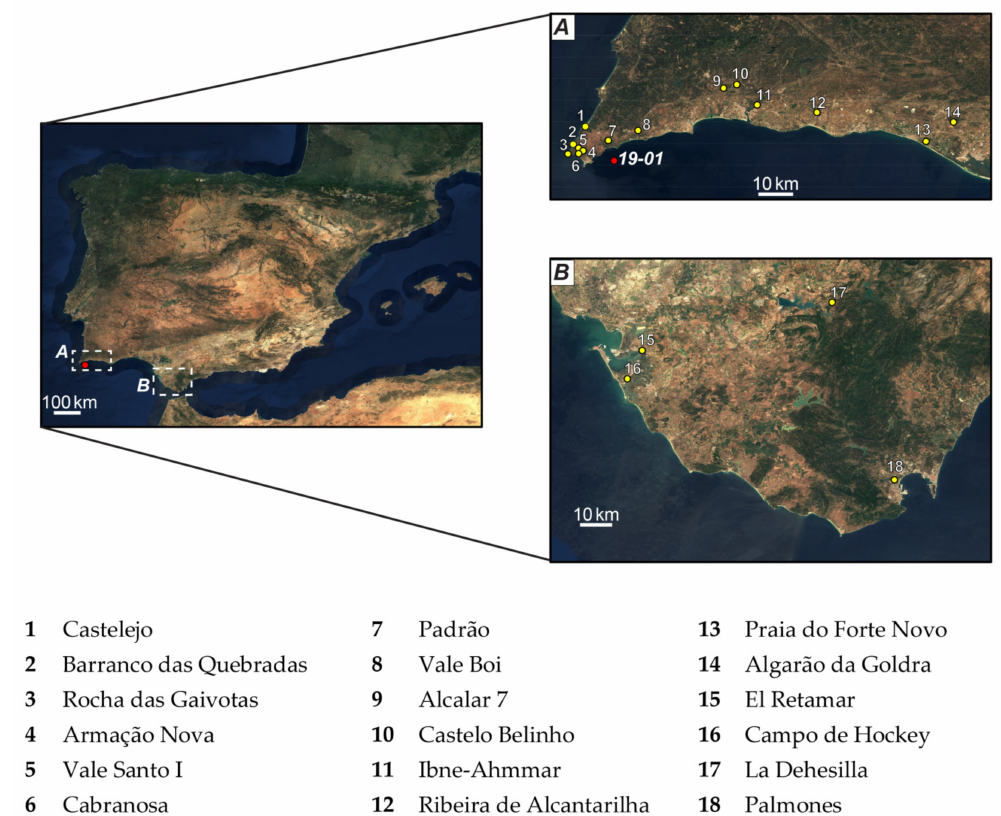
Figure 1. Map of the Iberian Peninsula indicating: the sediment core 19-01 (red dot), the distribution of archaeological sites in the region of the Algarve ( A ), and in the Southeast of the Gulf of C á diz ( B